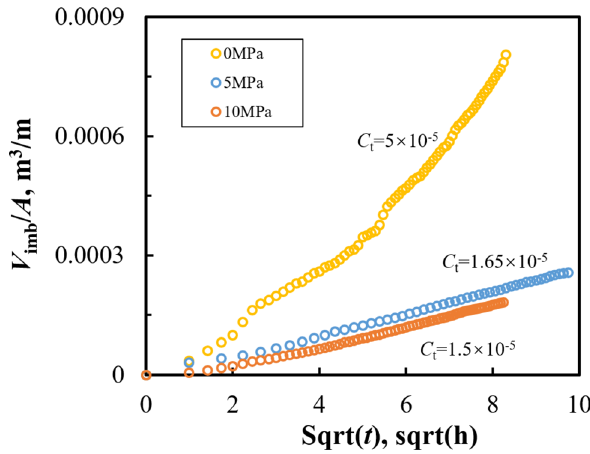
Fig. 6 Rock sample imbibition curves with different confining pres- sure (water, co-current imbibition)